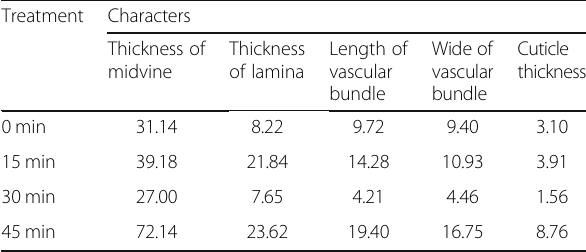
Table 4 Effect of UV-B radiation exposure time on leave anatomical structure of Spathyiphyllum cannifolium plant Treatment Characters Thickness of midvine